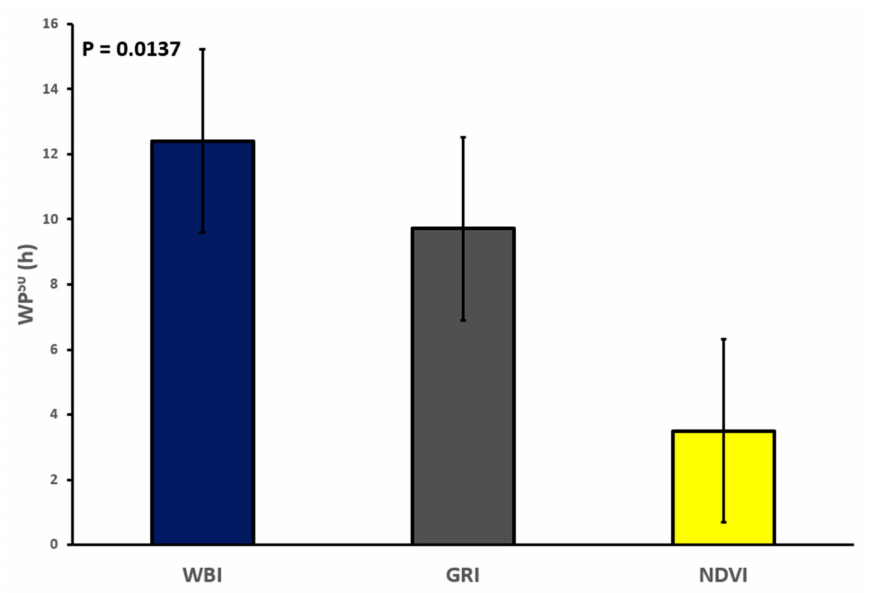
Figure 5. Values of 50% wilt prediction time (WP 50 ) for three vegetation indices, the water band index (WBI), green-to-red ratio index (GRI), and normalized difference vegetation index (NDVI). The WP 50 was calculated as the difference in time between the drought stress indication time and observed 50% wilt. Data were pooled across six replications of two grass species: creeping bentgrass and hybrid bermudagrass, and three soil textures: sand, loam, and clay.